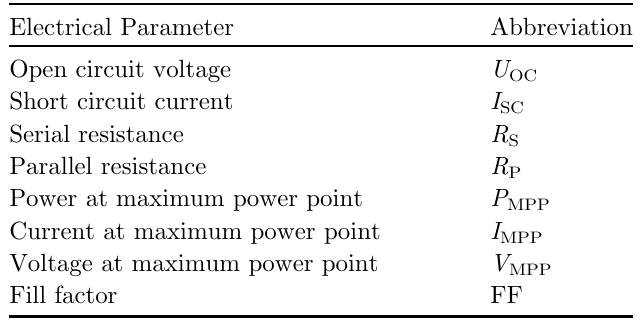
Table 2. Overview of electrical measurement